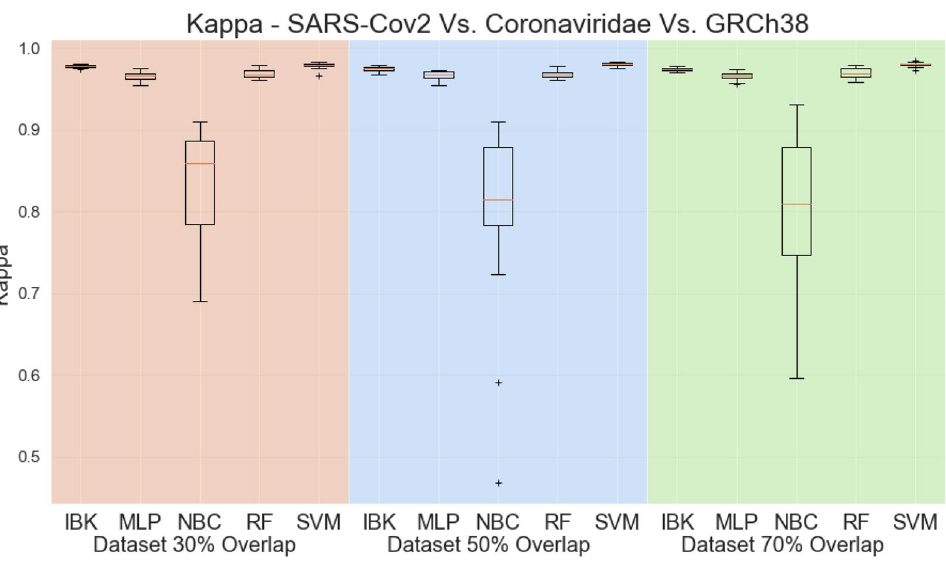
Figure 17. Kappa Statistic for SARS-CoV-2 test